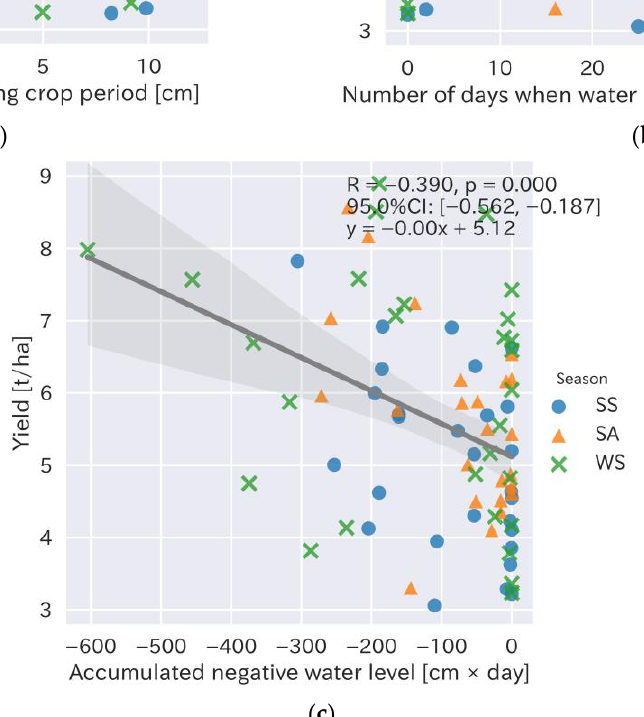
Figure 3. Relationship between the rice yield and water level during the crop cultivation period. ( a ) Average water level during the crop cultivation period (cm); ( b ) days of negative water levels during the crop cultivation period (days); ( c ) accumulated negative water level during the crop cultivation period (mm). Circles, triangles, and crosses show data from the spring–summer (SS), summer–autumn (SA), and winter–spring (WS) seasons,